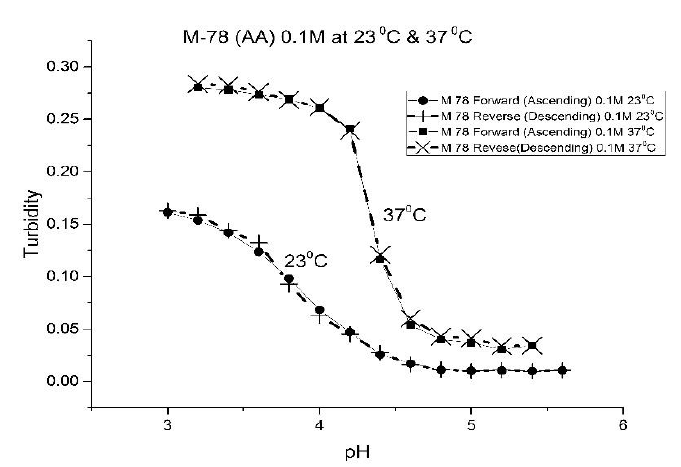
Figure 1. Ascending and descending pH profiles of polymer particles of M-78 (NIPA copolymerized with AA) at 23 °C and 37 °C. Solid line = ascending pH profile. Dashed line = descending pH profile.